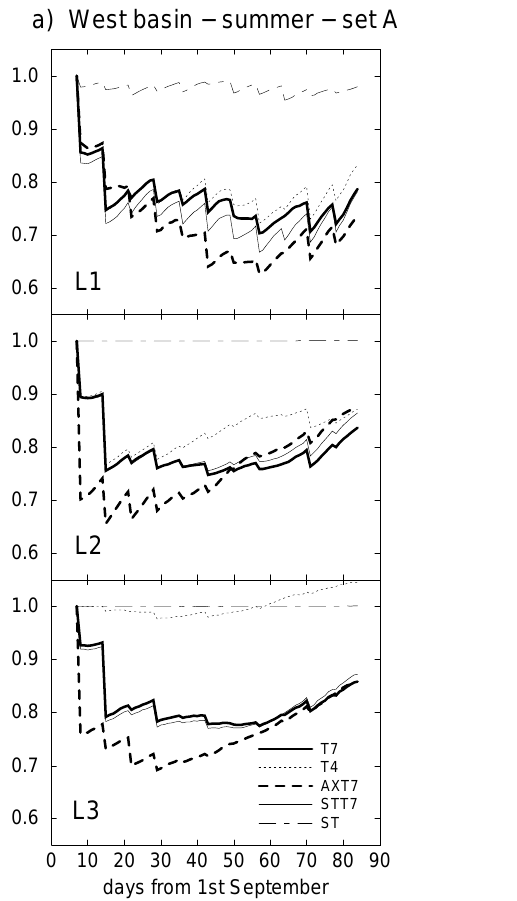
error reduction is reached in L1 around days 55–60 (Fig.